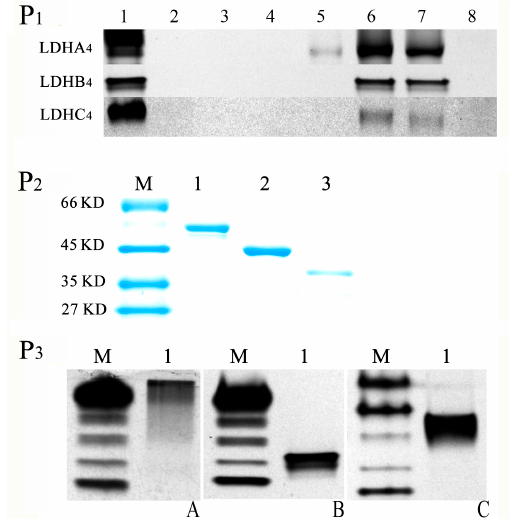
Figure 3. Purification and identification of LDH-A 4 , LDH-B 4 , and LDH-C 4 . ( P 1 ) Native PAGE of recombinant protein washed by imidazole at different concentrations. Lane 1: the supernatant before purification, Lane 2–7: collected elutions from Ni-NTA resins eluted with 10, 20, 50, 100, 250 and 500 mmol/L imidazole buffers, respectively. Lane 8: the remainder in the purified supernatant; ( P 2 ) SDS-PAGE analysis of the purified LDH-A 4 , LDH-B 4 , and LDH-C 4 . Lane 1–3 represented theLDH-A 4 , LDH-B 4 , and LDH-C 4 , respectively; M: marker; ( P 3 ) Identification of purified LDH-A 4 , LDH-B 4 , and LDH-C 4 . Lane 1 represents ( A ) LDH-A 4 ; ( B ) LDH-B 4 , and ( C ) LDH-C 4 by Native polyacrylamide gel electrophoresis (PAGE), respectively. M: marker was prepared by mixed kidney and skeletal muscle tissues of plateau pika.